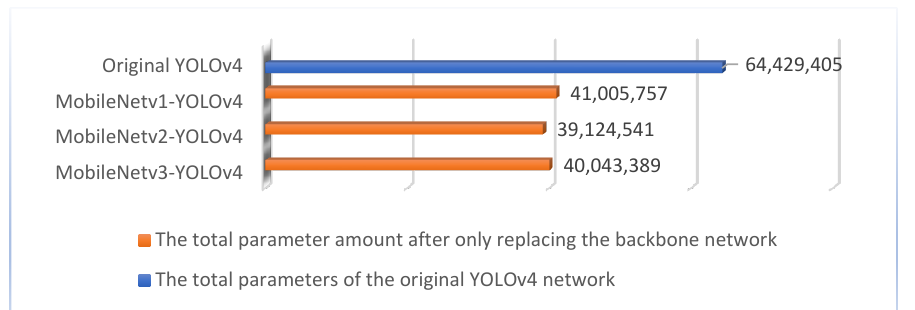
Figure 8. Comparison of parameters before and after replacing only the backbone network.